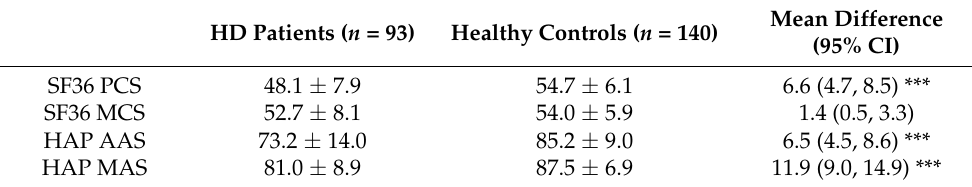
Table 2. Results of the